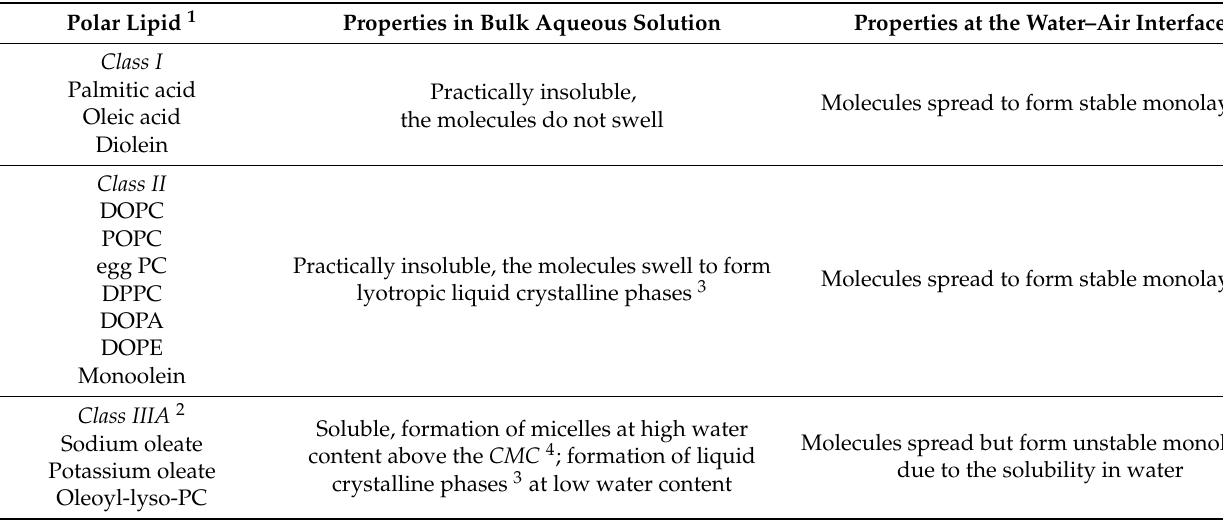
Table 1. Examples of biological polar lipids, grouped according to the classification of Small